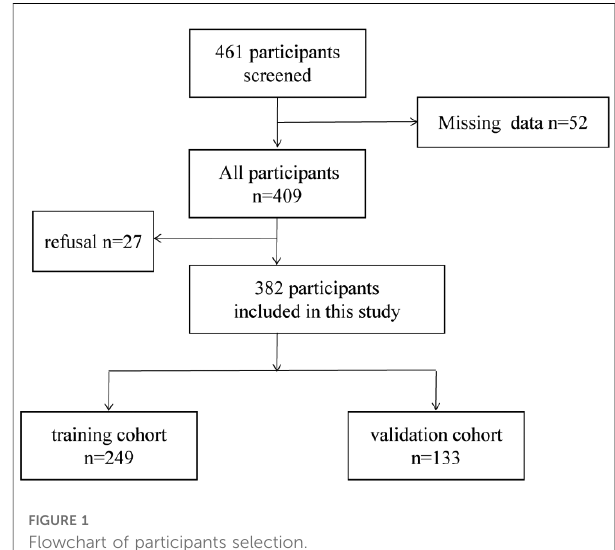
FIGURE 1 Flowchart of participants